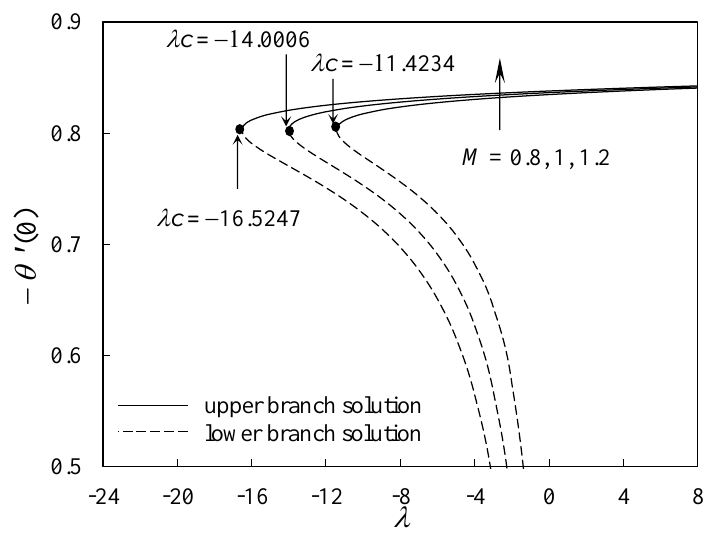
  0  (cid:48) ( 0 ) with λ for several values of M for Ag-water nanofluid. with  for several values of M for Ag-water nanofluid. Figure 19. Variation of − θ